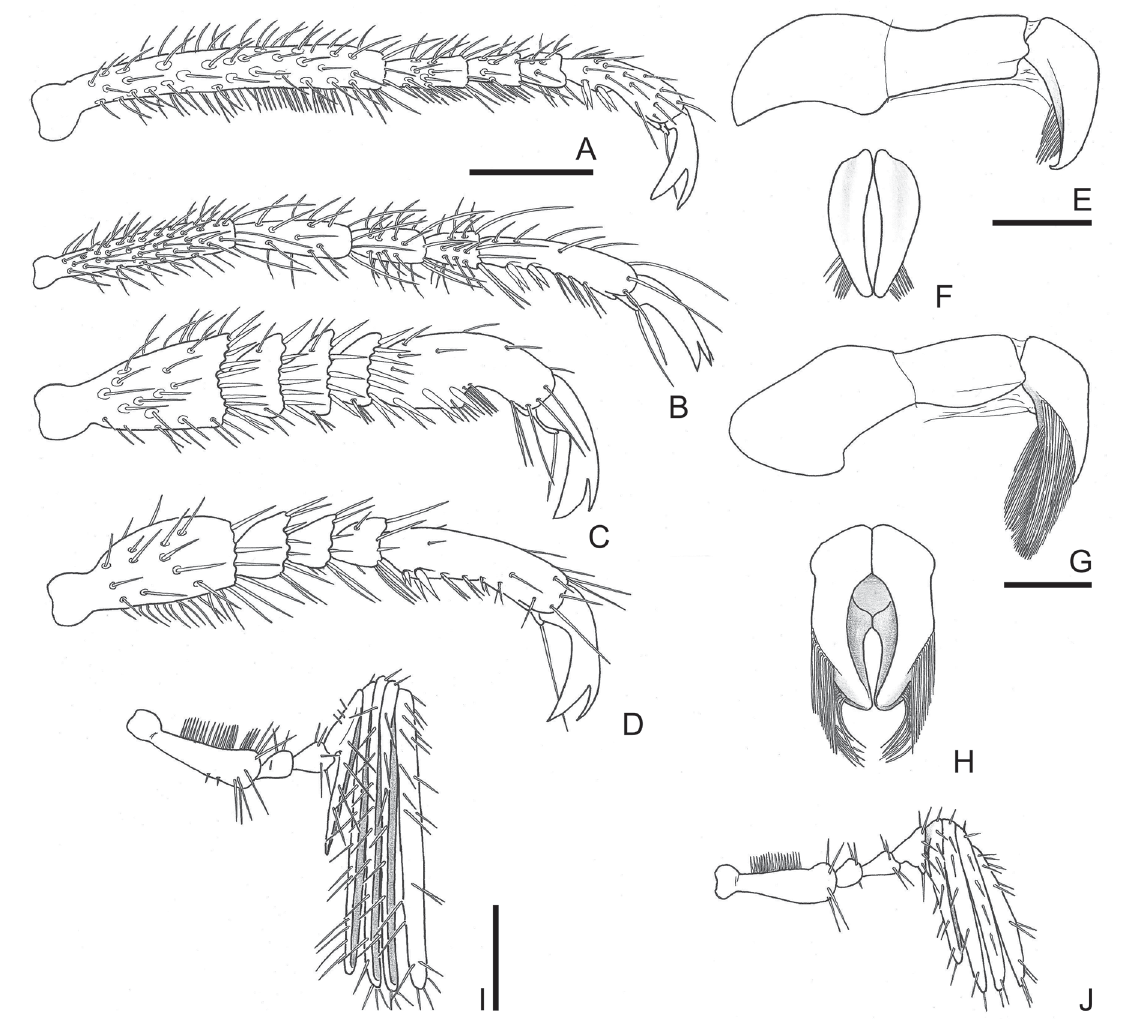
Fig. 4. A–C . Male metatarsus. D . Female metatarsus. E–H . Aedeagus (lateral, parameres apex). I–J . Antenna (♂, ♀). A . Plectris tomentosa LePeletier de Saint-Fargeau & Audinet-Serville, 1828. B , E–F . Anomonyx uruguayensis Moser, 1921. C–D , G–J . Oedichira pachydactyla Burmeister, 1855. Scale bars = 1